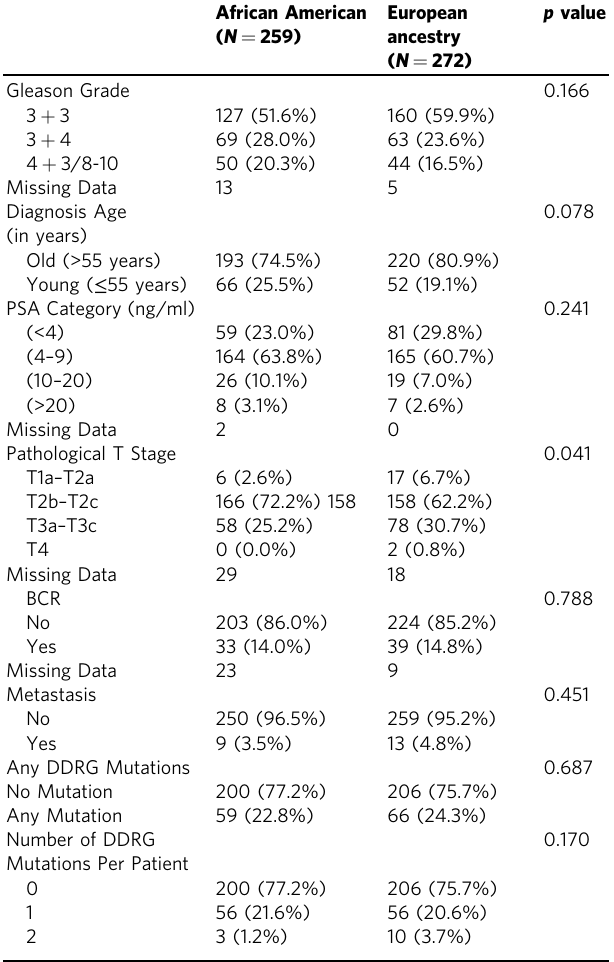
Table 1 Clinico-pathologic characteristics and DDRG mutation status of 531 patients with prostate cancer strati fi ed by